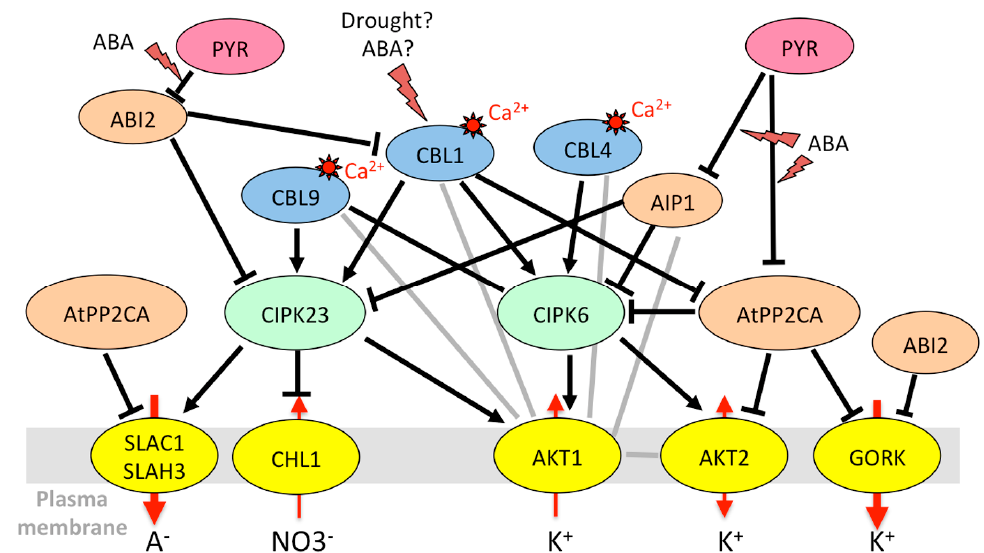
Figure 5. Model for the CIPK/CBL/PP2C network regulating both Shaker and anion channels in Arabidopsis guard cells. See Figure 1 for details of the legend. The symbol “?” indicates that the CBL1 protein, involved in stomatal movements together with CBL9 [185], is accumulated in whole leaf tissues after drought and ABA treatments [162], but this remains to be confirmed specifically in guard